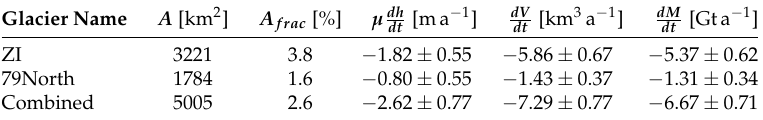
Table 4. Mean TDM dh measurements and volume change rates dV dt in the time period between 01/01/2011 and 31/12/2013. Sub-aqueous volume changes are not considered in this table. A is the area observed by TDM and represents only a fraction A frac of the entire